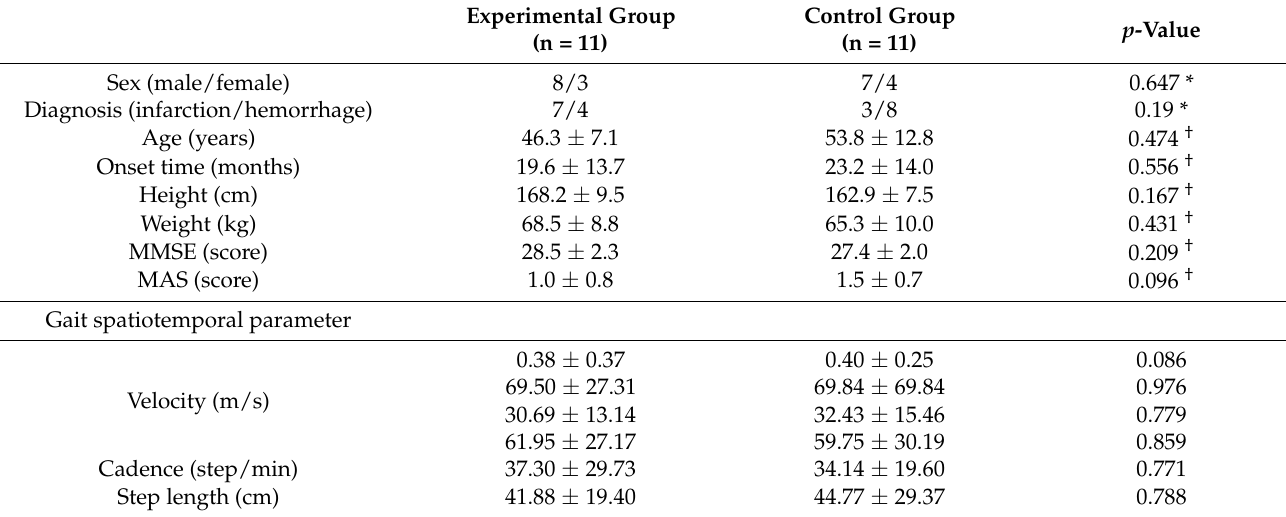
Table 1. Baseline characteristics of the participants.